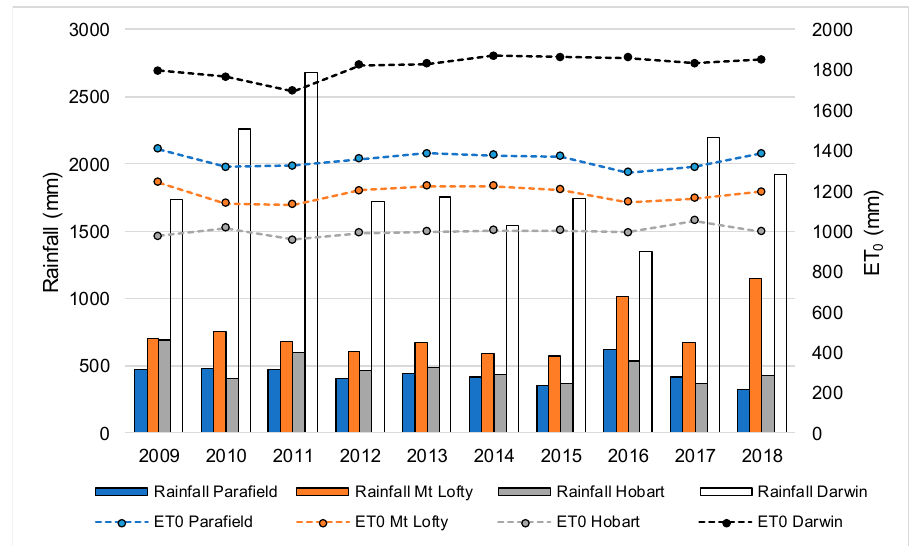
climate data from Bureau of Meteorology [51].